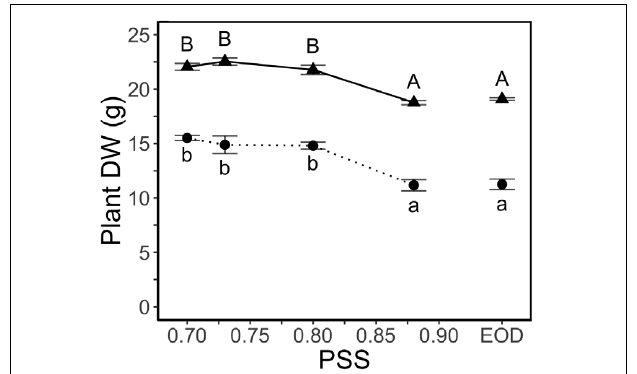
FIGURE 2 | DW of tomato plants in relation to four levels of PSS and an EOD-FR treatment (EXP1: • , lower case letters; EXP2: (cid:78) , capital letters). Plants had been grown for 4 weeks at the different light treatments. Error bars represent SEM ( n = 3). Different letters indicate significantly different means ( P <